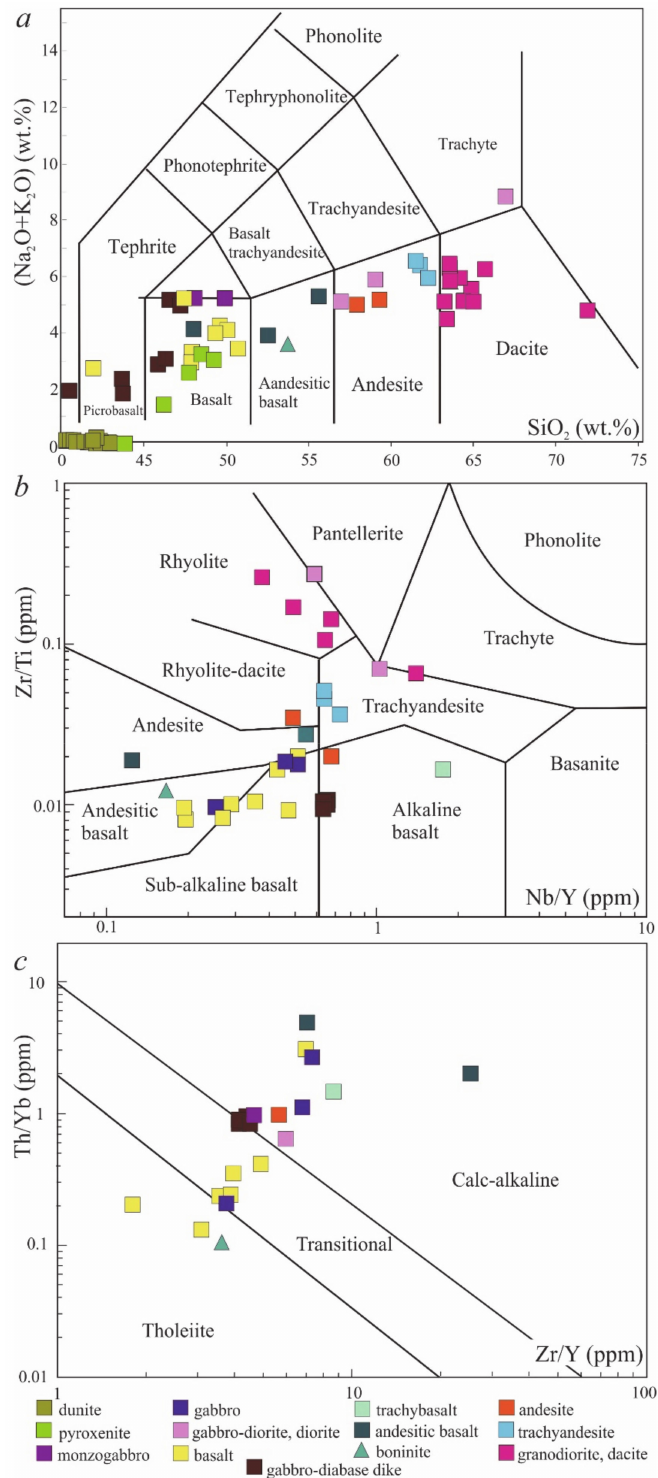
Figure 13. Geochemical diagrams for mafic, intermediate, and felsic of the USM rocks: ( a ) Total alkali-silica (TAS) diagram for magmatic rocks [57]; ( b ) Nb / Y vs. Zr / Ti diagram to distinguish between subalkaline and alkaline basalts for altered rocks [58]; and ( c ) Zr / Y vs. Th / Yb diagram to distinguish between the tholeiite and calk-alkaline series for altered rocks